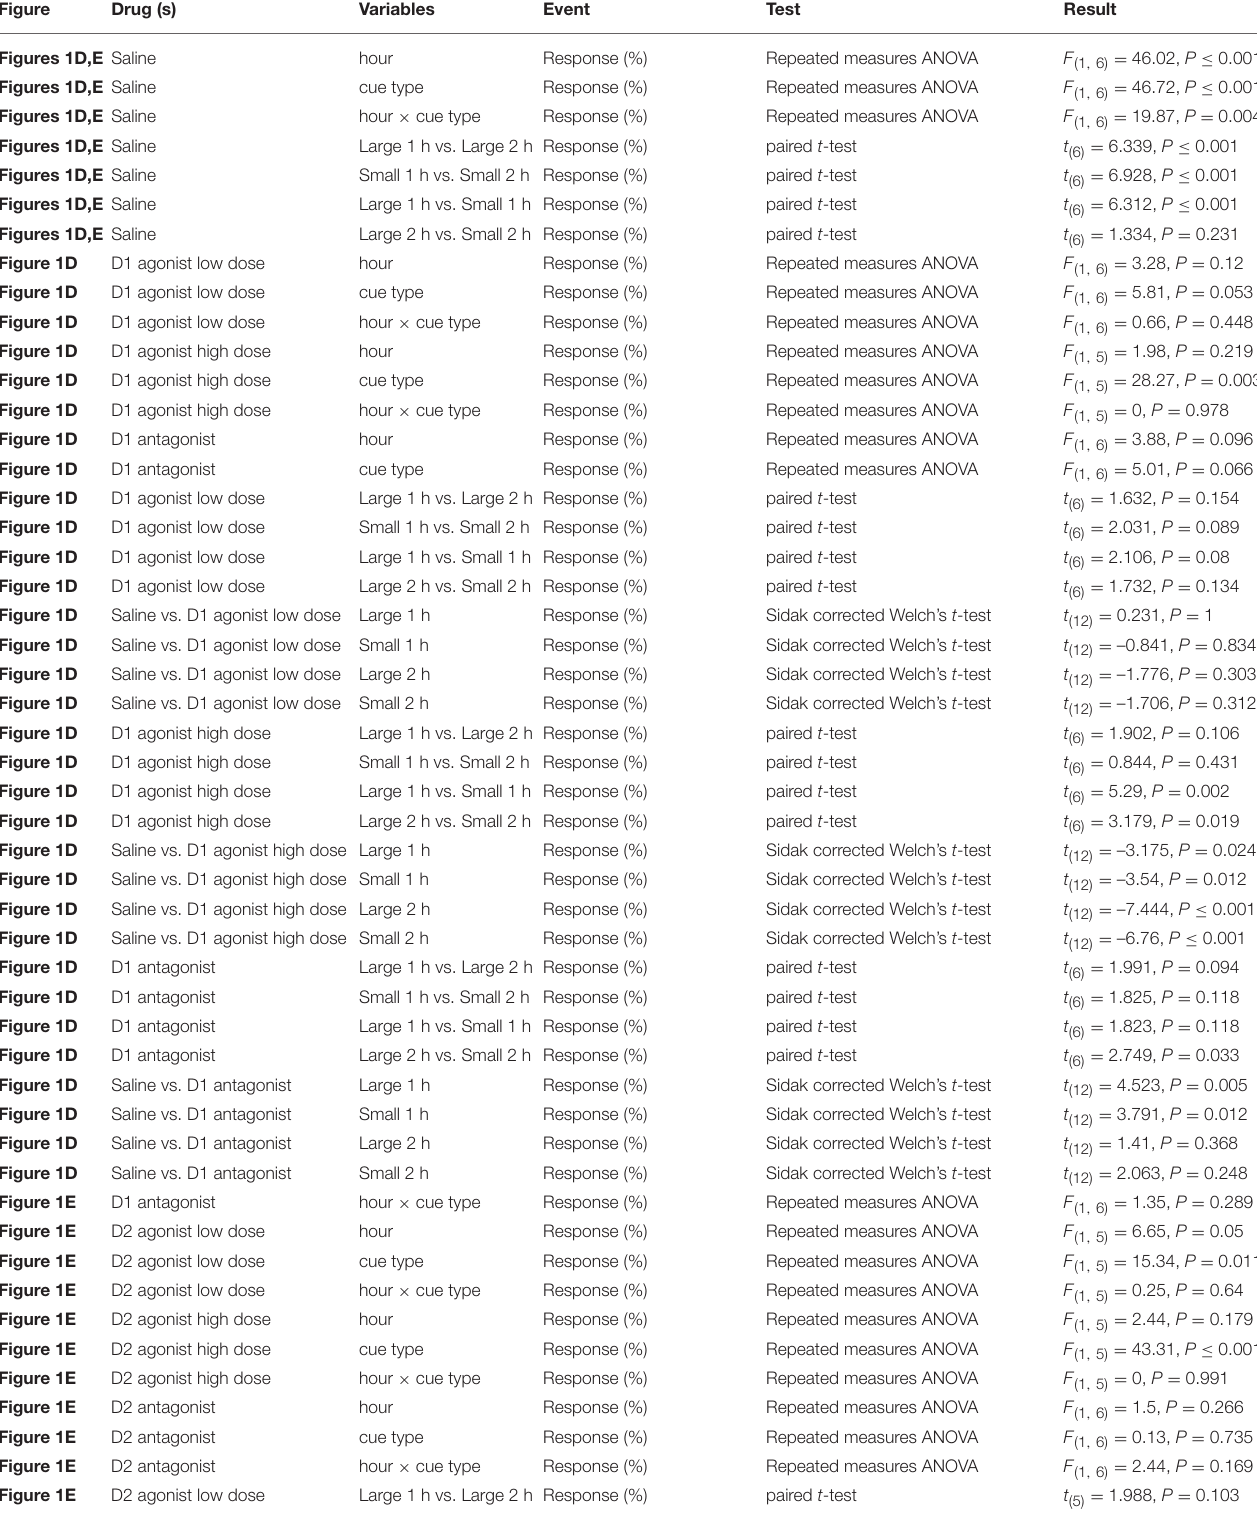
TABLE 1 | Statistical results. Figure Drug (s) Variables Event Figures 1D,E Saline